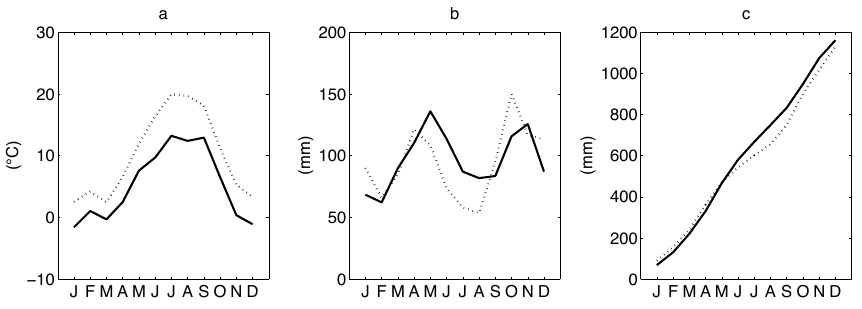
Fig. 3. Mean monthly temperature in the backcast (solid) and forecast (dotted) scenario (a) ; total monthly precipitation (b) ; and cumulate precipitation over the year (c) with downscaled RACMO RCM.